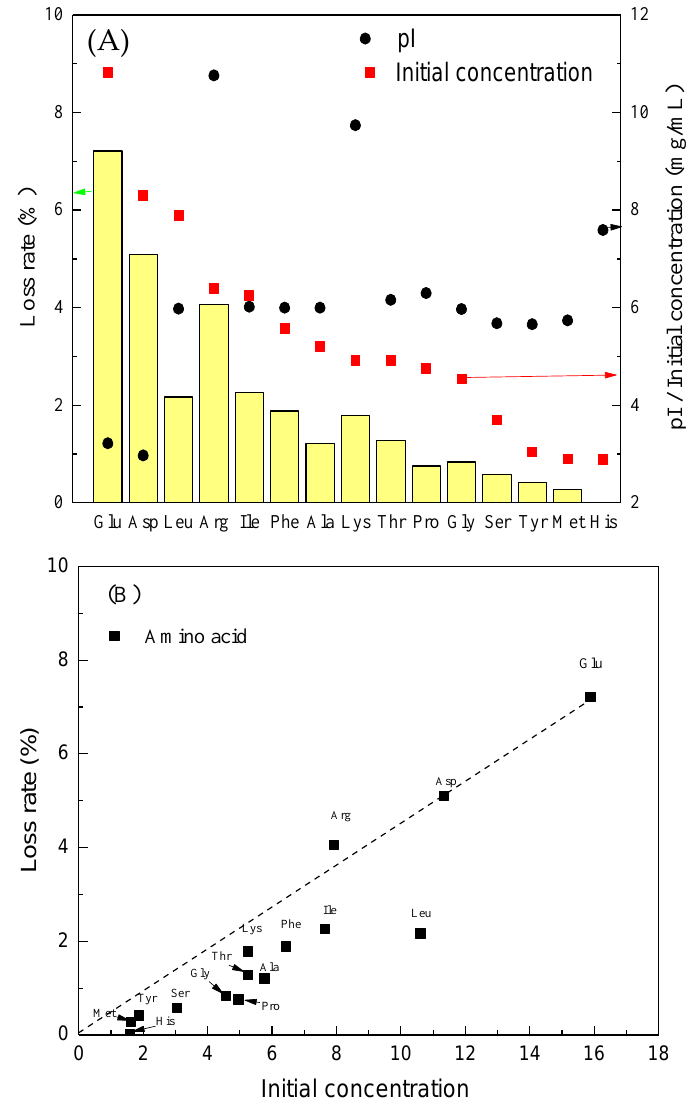
Figure 7. ( A ) Overview of the loss rate of amino acids, isoelectric point, and their initial concentration during the desalination process at pH = 5. ( B ) The relationship between the loss rate of amino acids and their initial concentration. pI: isoelectric point.